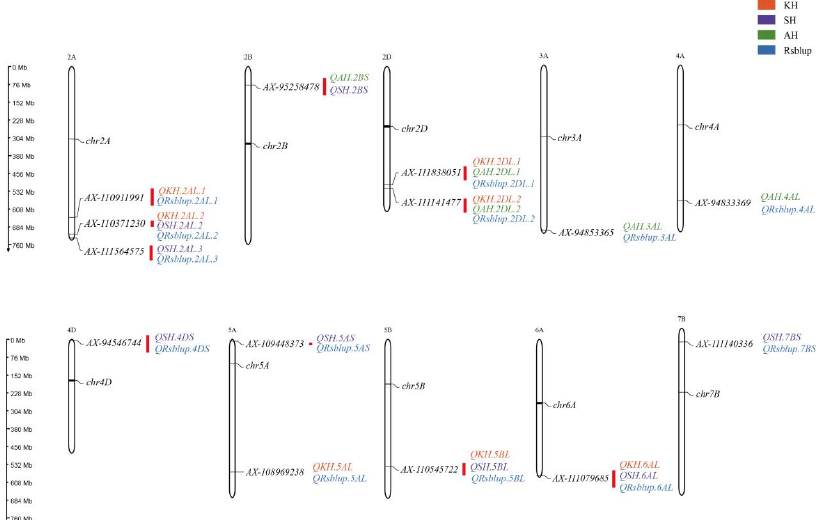
Figure 3. The physical position of the 14 RS content-related QTL. The centromere structure was marked by black bars. QTL detected from various locations were marked by four colors. KH, SH, AH, and Rsblup represent QTL detected from Kaifeng, Shangqiu, Yuanyang, and BLUP. Table 2. Evaluation of the superior alleles in significant SNP.